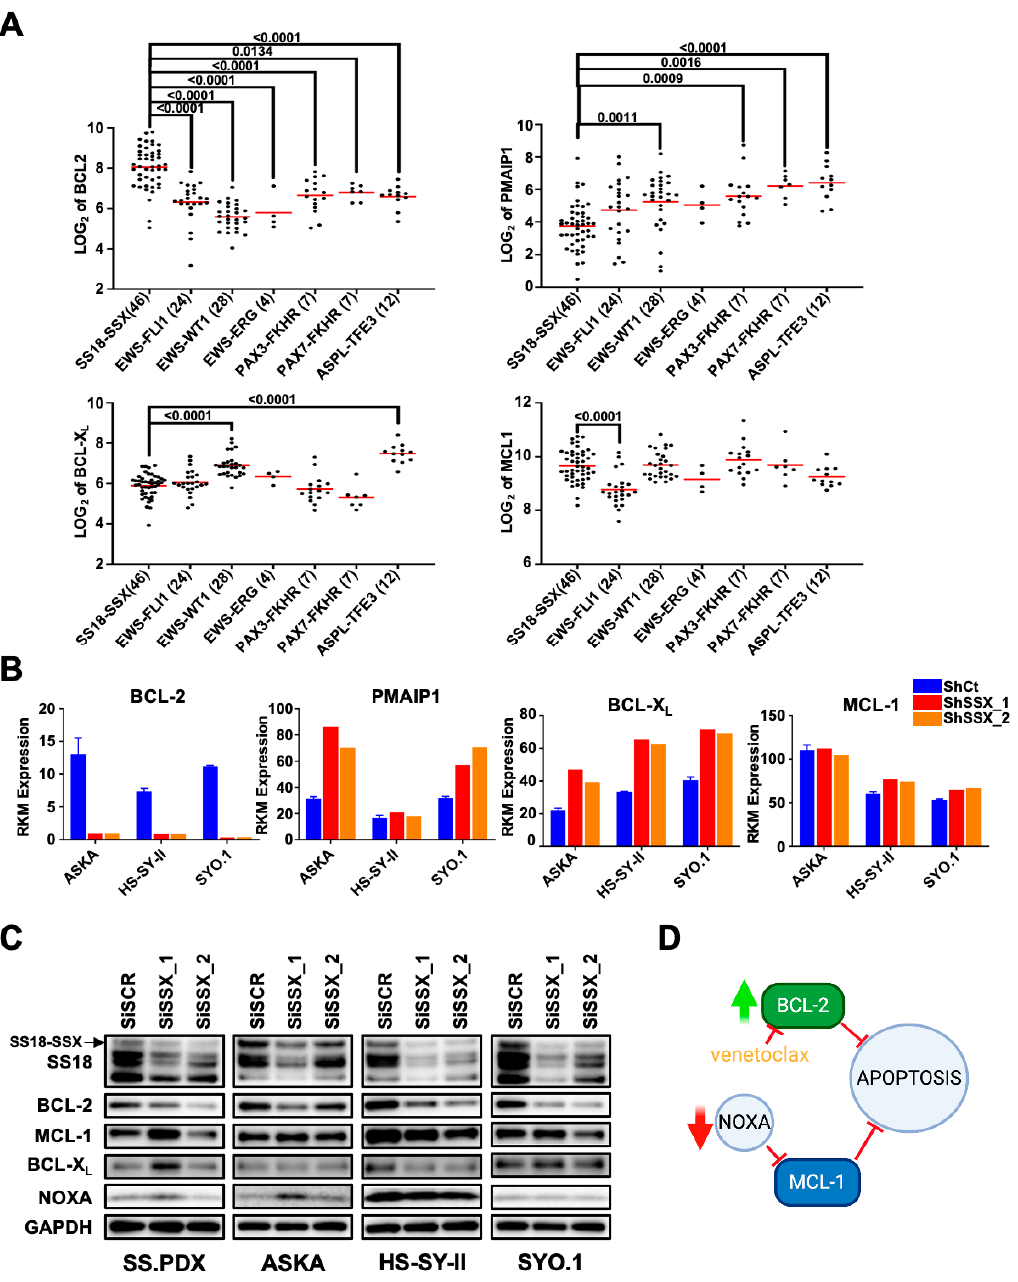
Figure 1. Synovial sarcoma tumors demonstrate increased expression of BCL-2 and decreased expression of NOXA. ( A ) RNA expression levels of key BCL2 family members from fusion-gene driven sarcoma tumor samples. Samples grouped by fusion gene, with sample size shown. Red line indicates mean. Student’s t -test was used to compare SS18-SSX to other fusion gene groups; p values less than 0.05 are displayed. ( B ) RNA expression levels of key BCL2 family members in ASKA, HS-SY-II, and SYO.1 SS cell lines after shRNA knockdown of SS18-SSX. Two different shRNA constructs are compared to a scramble control. ( C ) Western blot analysis of BCL-2 family proteins in an ex vivo cell line SS.PDX, and cell lines ASKA, HS-SY-II, and SYO.1 after SiRNA knockdown of SS18-SSX. Two separate siRNA constructs are compared to scramble control. ( D ) Our model of BCL-2 family member interactions in synovial sarcoma; the SS18-SSX fusion gene upregulates the anti-apoptotic protein BCL-2. SS cells show low NOXA expression independent of fusion gene expression. Low expression of NOXA, an endogenous inhibitor of the anti-apoptotic protein MCL-1, offers an explanation for SS venetoclax